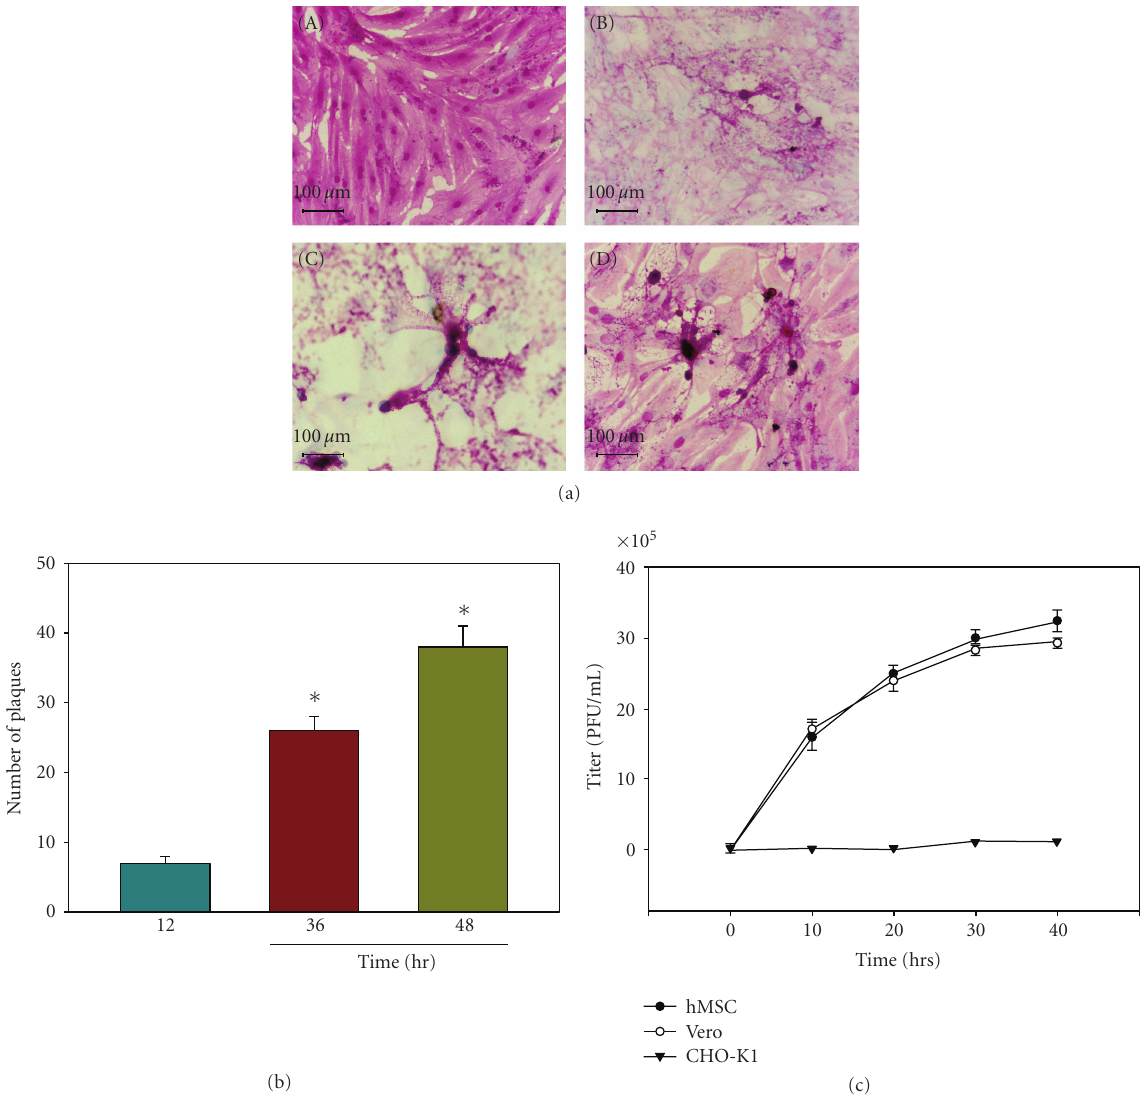
Figure 3: HSV-1 replicates in infected hMSCs. (a) Visualization and quantification of HSV-1 replication in cultured hMSCs. Confluent monolayers of hMSCs (5 × 10 6 ) were infected with HSV-1 KOS (804) virus at 0.01 PFU/cell were fixed and Giemsa stained at 0 hr (panel (A)) 12 hr (panel (B)) 24 hr (panel (C)) and 48 hr (panel (D)) postinfection. The numbers of plaques were visualized. (b) The number of plaques formed postinfection increased in a time-dependent manner. Error bars represent standard deviations. ( ∗ P < . 05), one way ANOVA. (c) Infectious yields of HSV-1 during viral infection were quantified. Confluent monolayers of Vero and hMSCs were infected with HSV-1 at 0.01PFU per cell for 90min at 37 ◦ C. Inoculums were harvested from both the cells at 10–40 h postinfection. The infectious virus-titer (PFU per milliliter) determined in triplicates in Vero cell by plaque assay indicates that the viral titer in cultured hMSCs increased overtime. Data represent the mean ± the standard deviation of results in triplicate wells in a representative